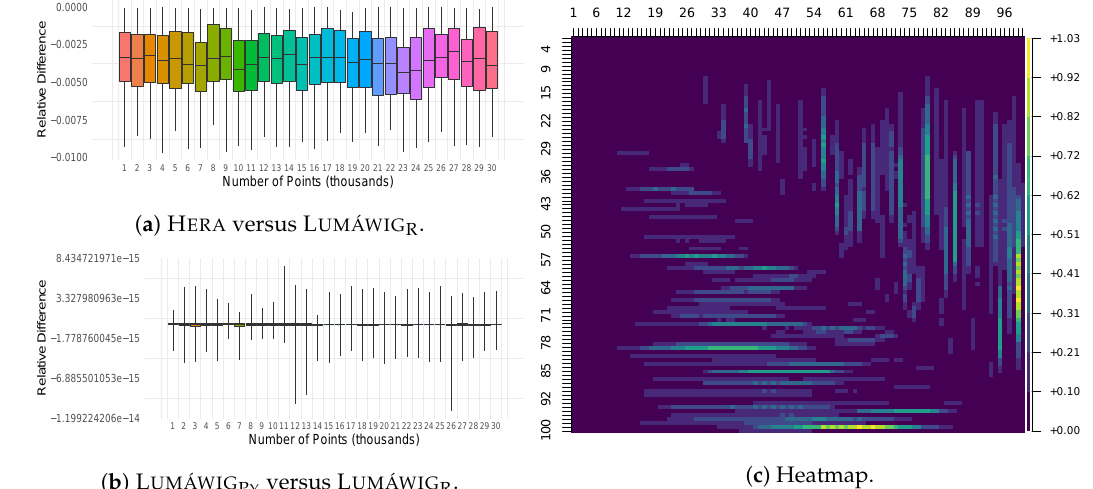
Figure 6. ( a , b ) Boxplots of relative differences between the bottleneck computation outputs of the indicated pair of implementations. ( c ) Heat map of the median running times of L UMÁWIG R . Each pixel represents the median running time (in seconds) for 100 computations of dimension zero bottleneck distance between diagrams. The number of points in the diagrams are in units of